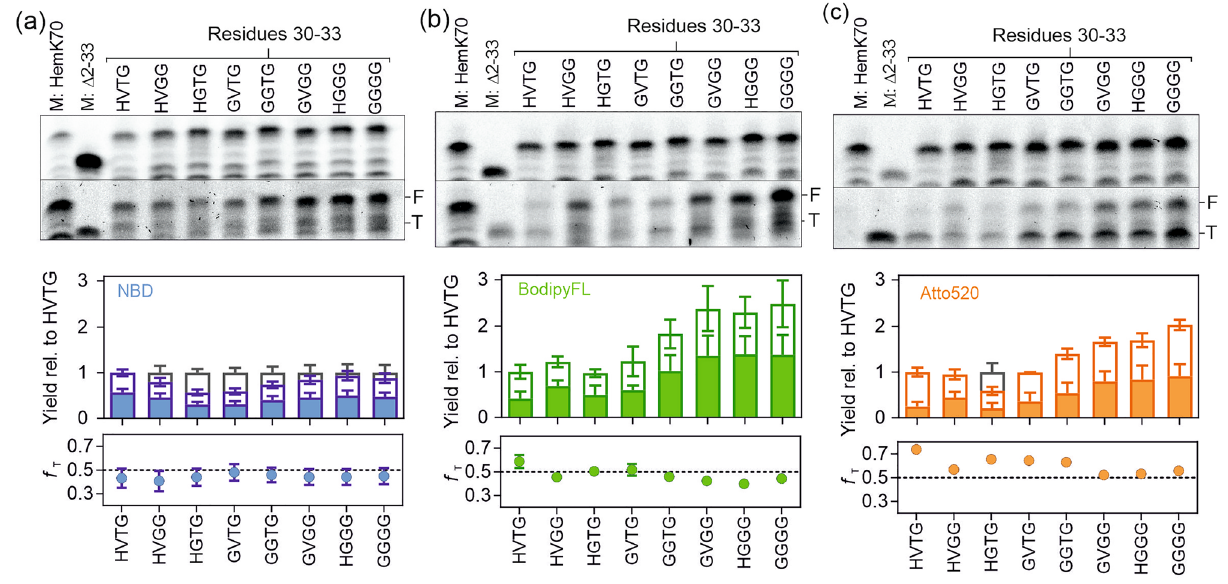
Figure 3. Effect of upstream residues −4 to −2 on RCys incorporation. Separation and quantification of translation products containing Atto655-Met1 and NBDCys34 was performed as described for Fig. 2. M: HemK70 marker was prepared from peptides containing N-terminal BodipyFLMet1 and Atto655Met1. The yield of F (filled bars) and T (open bars) products are shown relative to the native sequence context, HVTG. Error bars indicate the SEM values for n = 5 for NBDCys and n = 6 for BodipyFLCys and Atto520Cys. (a) NBD. (b) BodipyFL. (c)